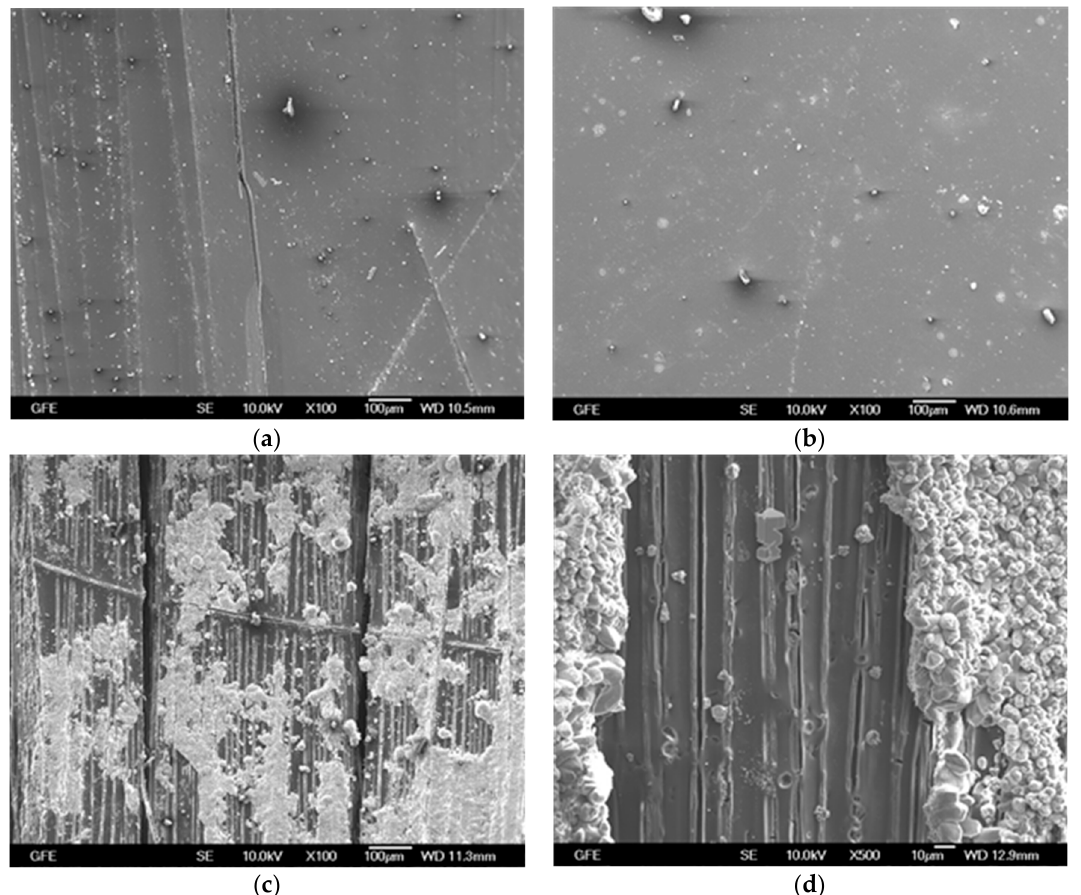
Figure 8. SEM images of E4: unpolarized reference ( a ), after polarization at level 1 ( b ), level 2 ( c ) and level 3 ( d ).